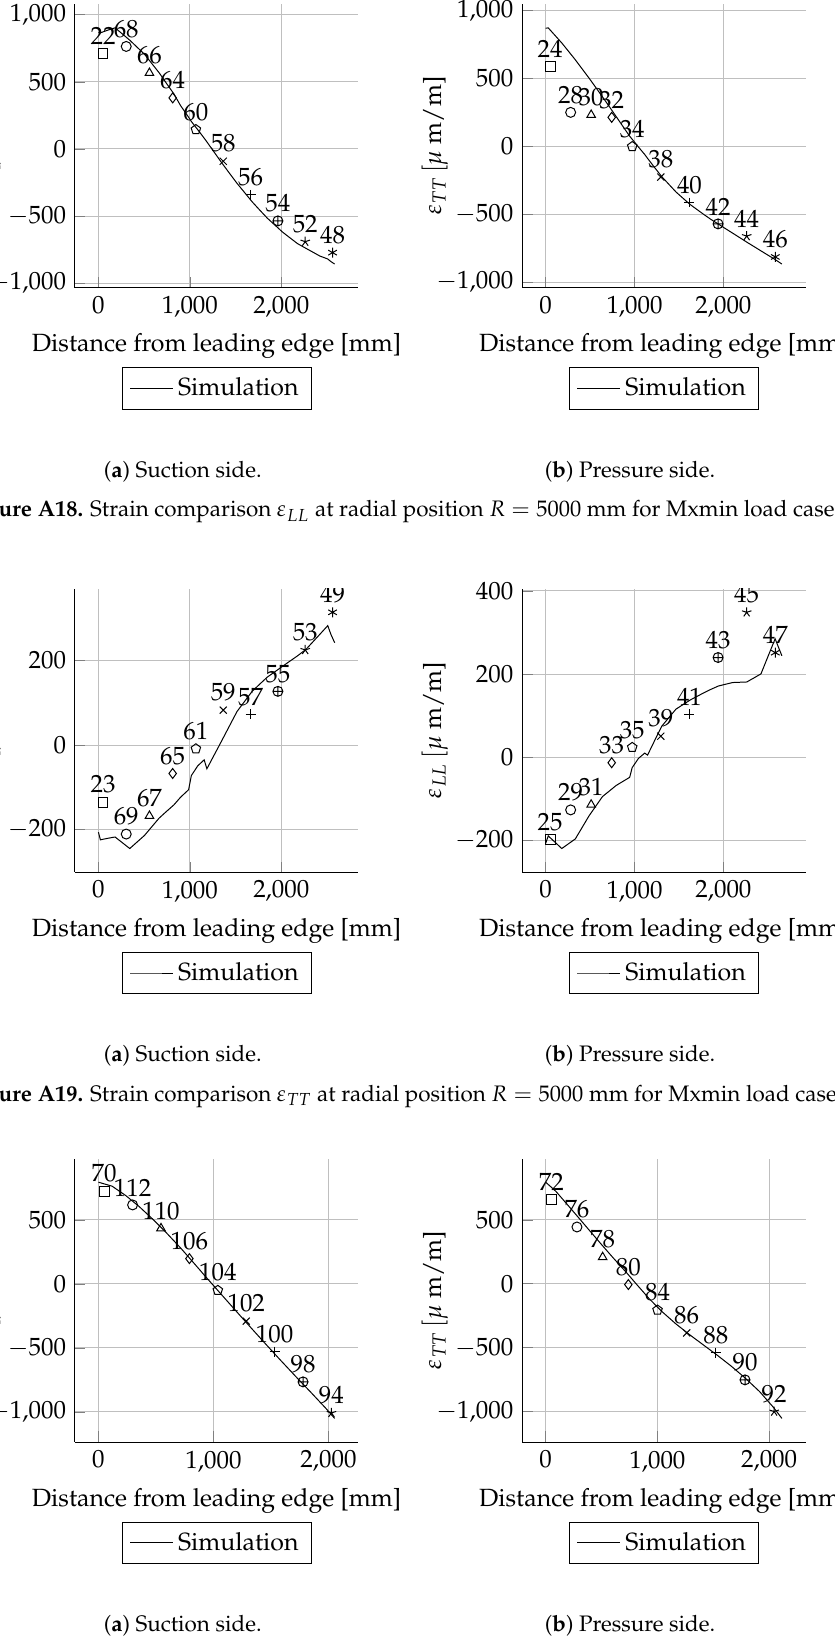
Figure A20. Strain comparison ε LL at radial position R = 8000 mm for Mxmin load